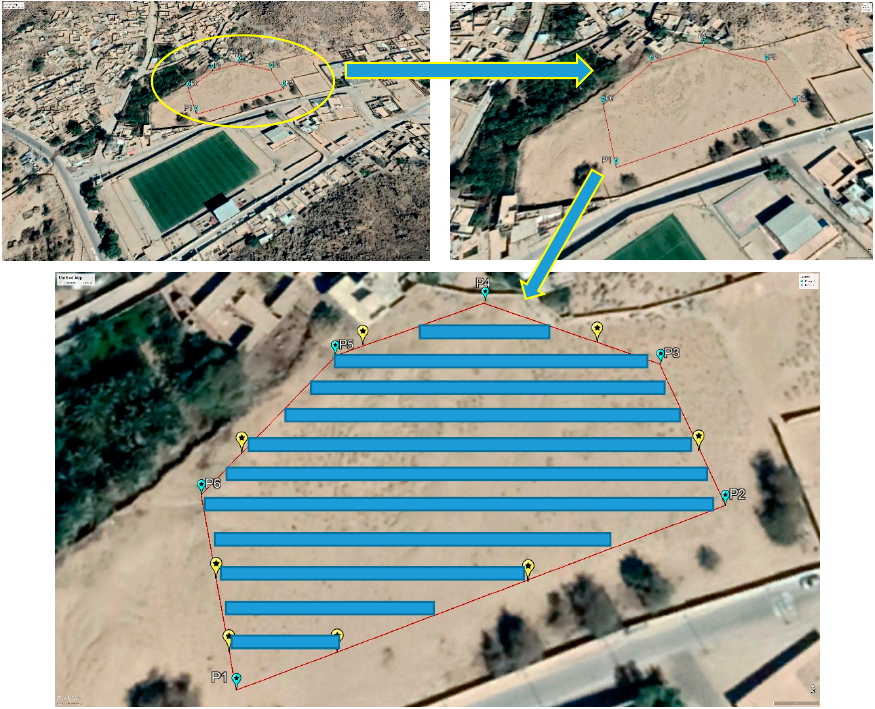
Figure 10. rows arrangement for minimum LCOE using HGWOSCA. Figure 10. Rows arrangement for minimum LCOE using